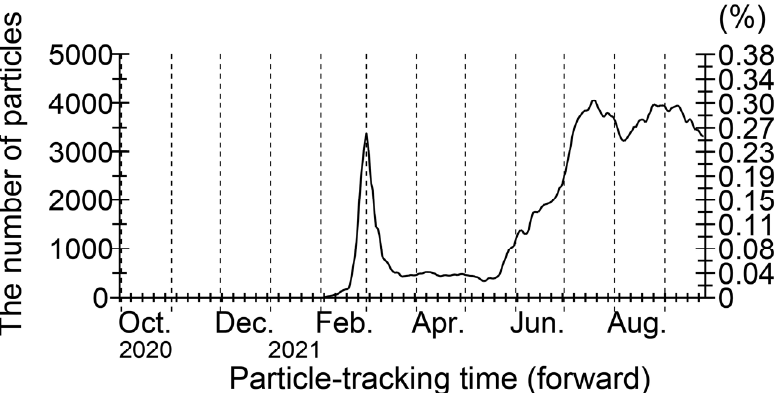
Figure 13. The number of particles that were distributed within the focal region of the study in prospective particle-tracking simulations. The left axis is the ratio of the number of particles to the total number of released particles (i.e., 1,314,240).